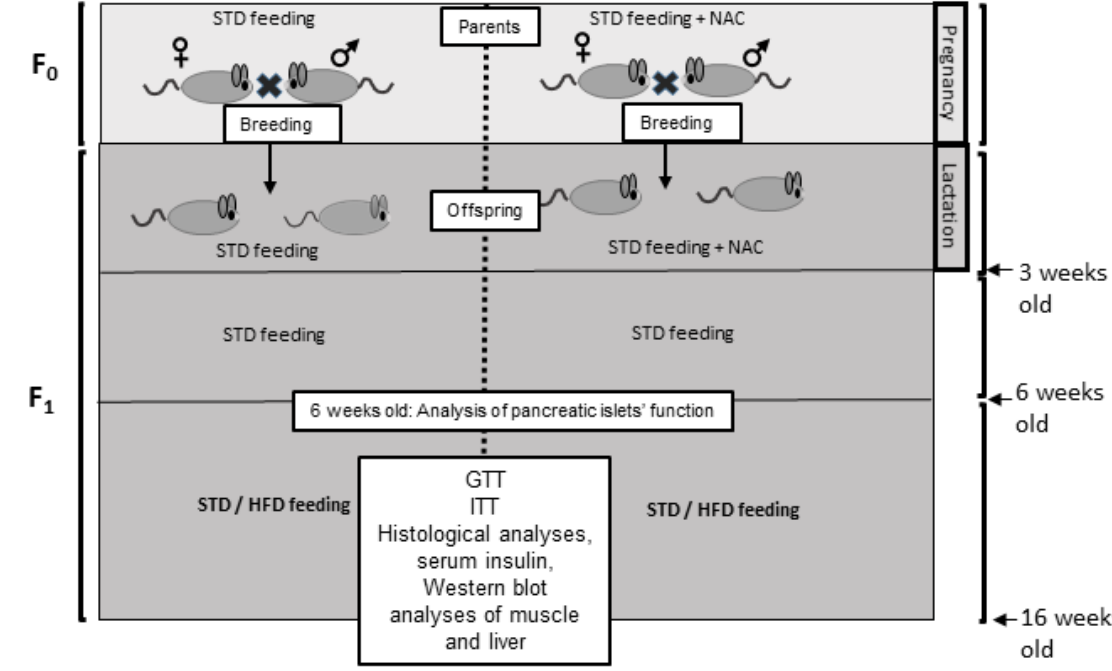
Figure 8. Study design. C57bl6/J mice were given STD with or without NAC supplementation during pregnancy and lactation. Offspring were separated at the age of 3 weeks. Analysis of islet mass and function was performed at age of 6 weeks. STD or HFD were given at age of 6 weeks till the end of the study.